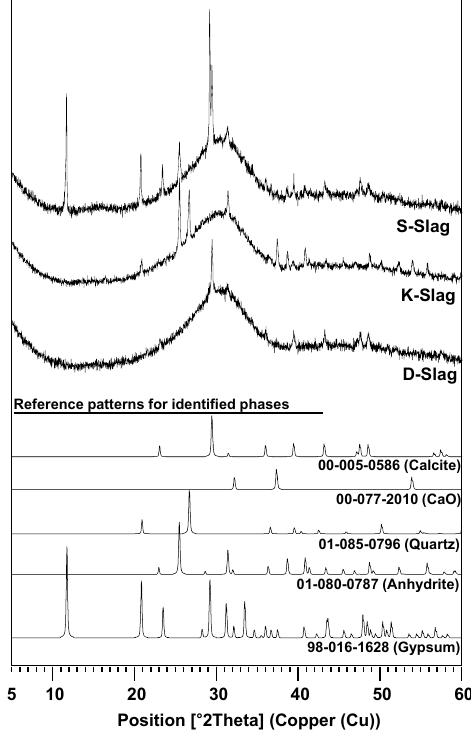
Figure 1. XRD patterns of raw ground granulated blast-furnace slag (GGBFS) samples with identified crystalline phases. Table 1. Mineralogical compositions of raw GGBFSs (wt.%) from XRD analysis.